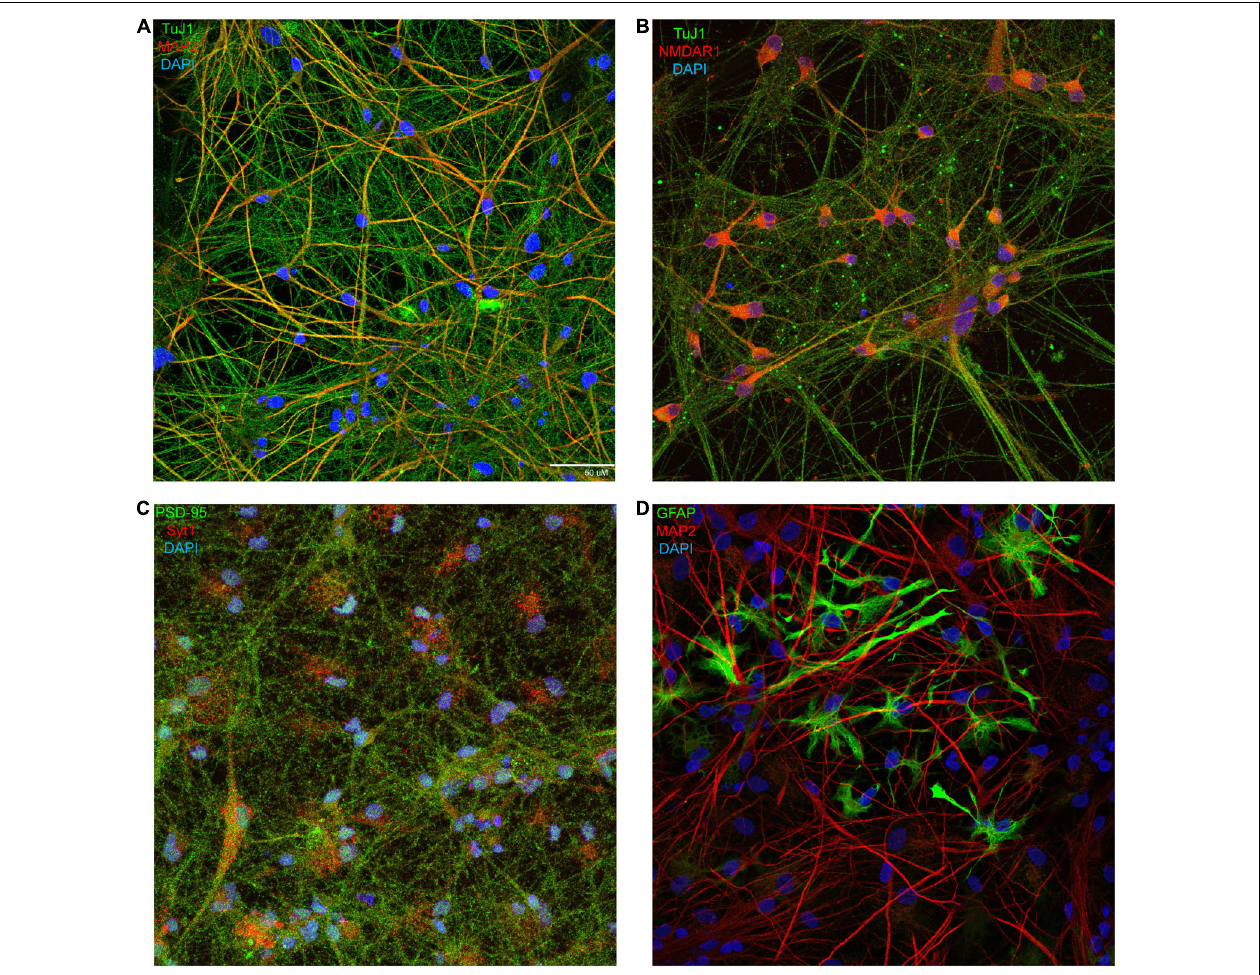
FIGURE 1 | Immunofluorescent confocal imaging and characterization of mature human neuronal cultures. (A–D) XCL-4 derived mature cultures (28–37 days in maturation media) were fixed, permeabilized, and stained for the mature excitatory neuron markers β -tubulin III [TuJ1; green; (A,B) ] and microtubule-associated protein 2 [MAP2; red; (A,D) ], the obligate NMDAR subunit, NMDAR1 [red; (B) ], the presynaptic marker synaptotagmin 1 [Syt1; red; (C) ], the postsynaptic marker postsynaptic density protein 95 [PSD-95; green; (C) ], and the astrocytic marker glial fibrillary acidic protein [GFAP; green; (D) ]. All cultures were counterstained with the nuclear stain DAPI [blue; (A–D)